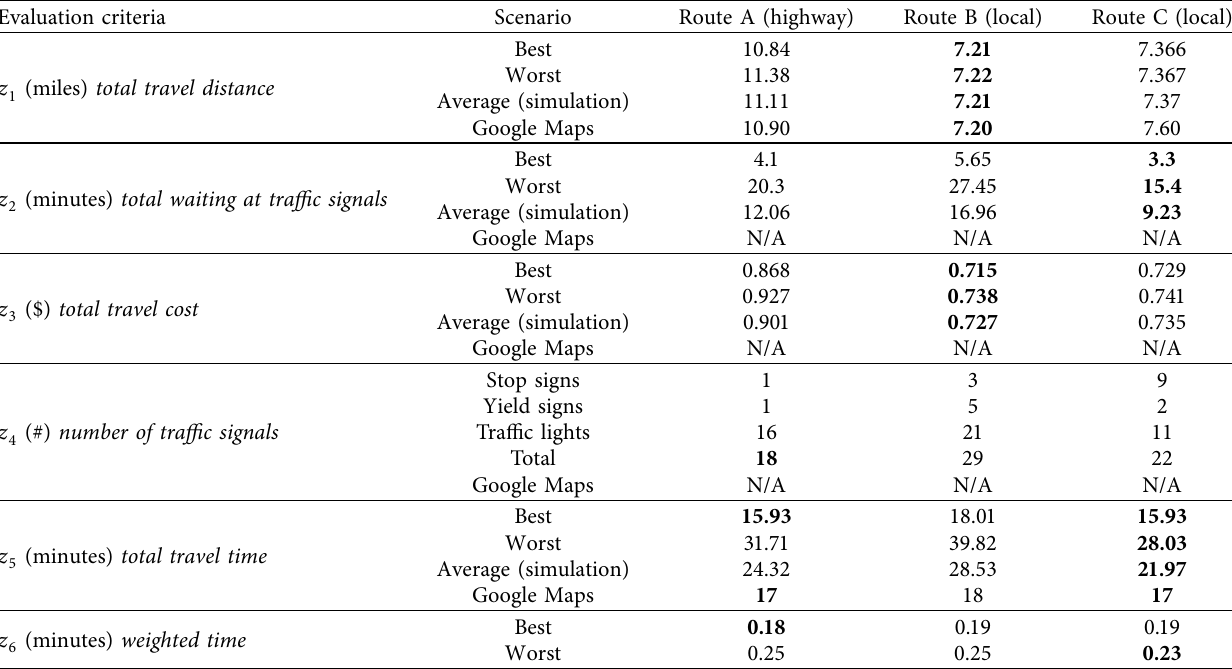
Table 6: Multiple criteria evaluation of short-distance